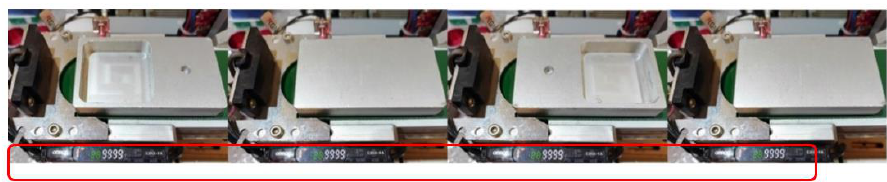
Figure 6. Test values of square blue material.